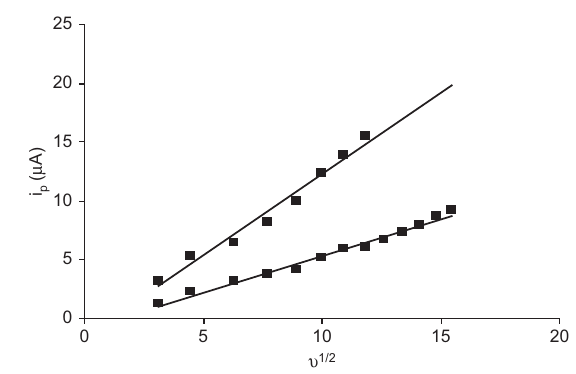
Figure 10 Relationship between the peak current of oxidation waves at + 1.05 V of 1.0 × 10 -4 m GTF (1) in the absence and (2) pres- ence of an excess DNA and the square root of scan